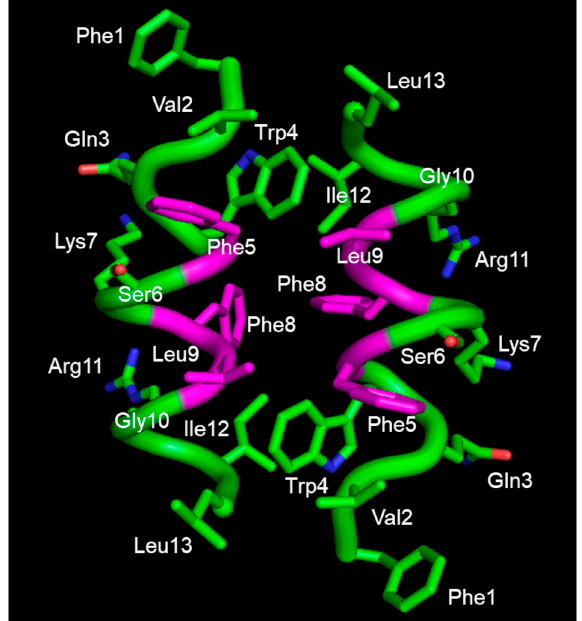
Figure 2. Structure of temporin L in LPS. Residues involved in dimer stabilization are indicated in magenta [67]. magenta